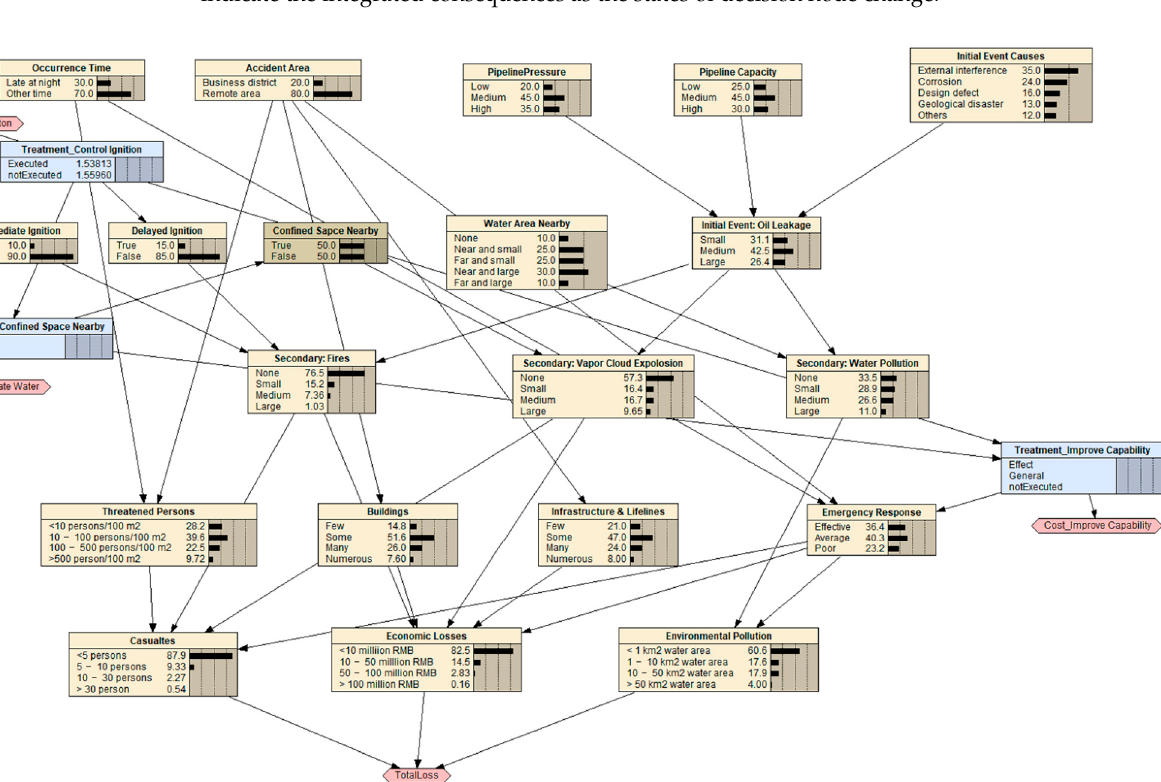
Figure 6. The BDN risk treatment model for oil pipeline accidents.